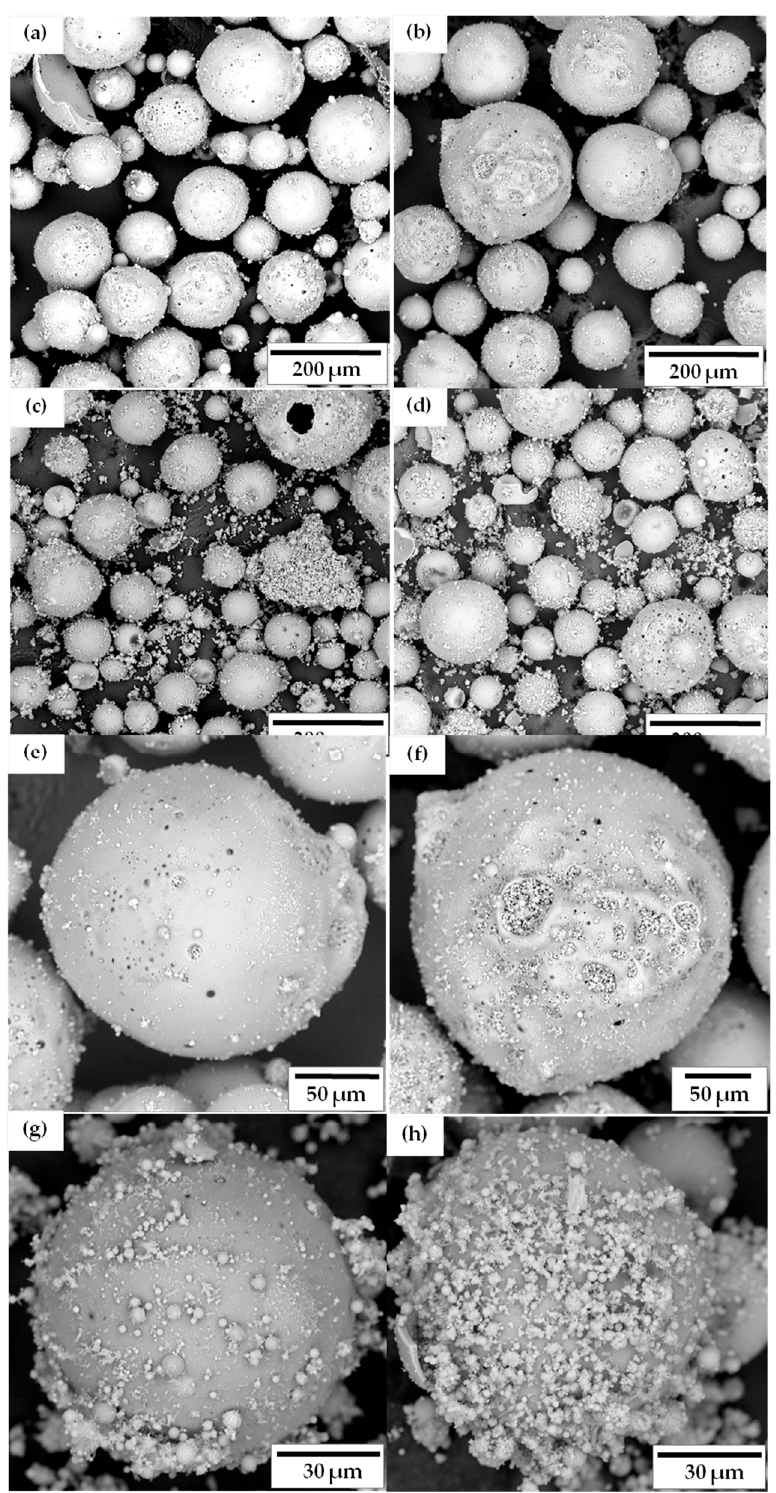
Figure 8. SEM images of cenospheres collected from the freshly prepared mixtures at different acetone / water ratios of ( a , e ) 100:0, ( b , f ) 80:20, ( c , g ) 50:50, and ( d , h ) 20:80, using fly ash / medium ratio of 1:5 and a 4-h soaking period. Here, (e–h) includes magnified SEM images selectively zoomed in on one cenosphere particle.